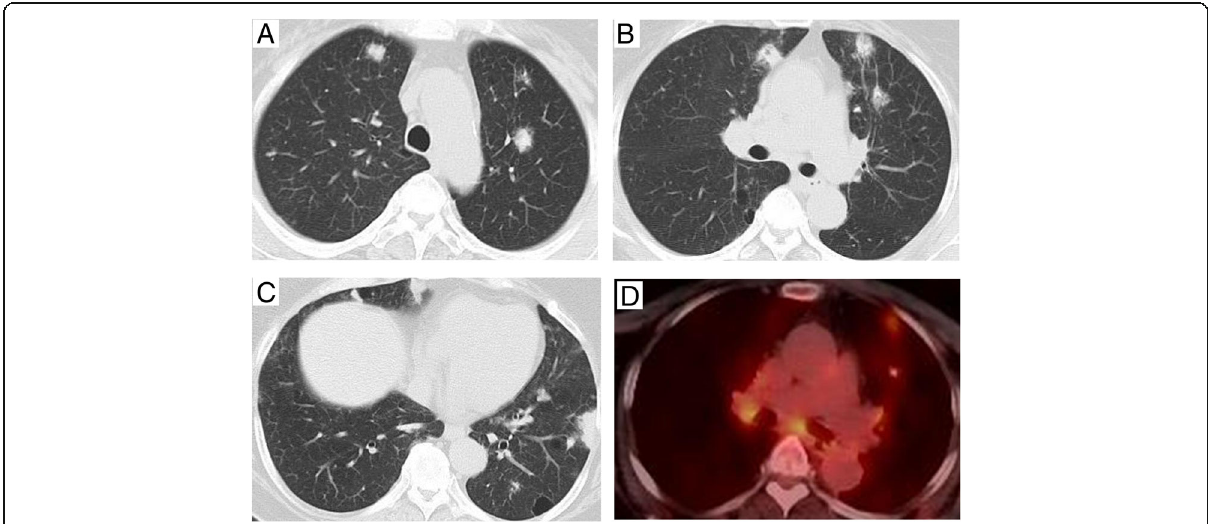
Fig. 1 a – c Chest computed tomography showed multiple nodules in the right S3, right S7, left S1 + 2, and left S8. d Fluorodeoxyglucose-positron emission tomography showed FDG accumulation in pulmonary nodules to the horizontal slice as b